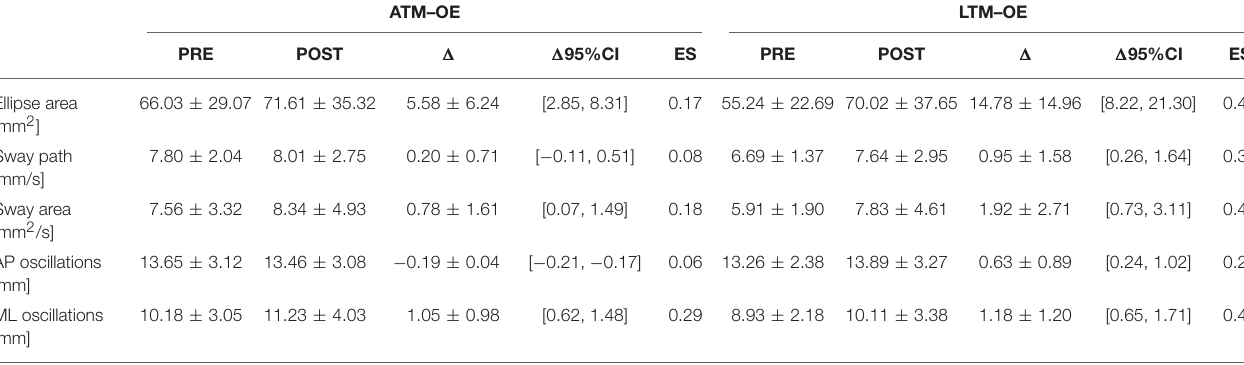
TABLE 1 | Classical postural parameters: comparison between the PRE and the POST values in the OE condition. ATM–OE